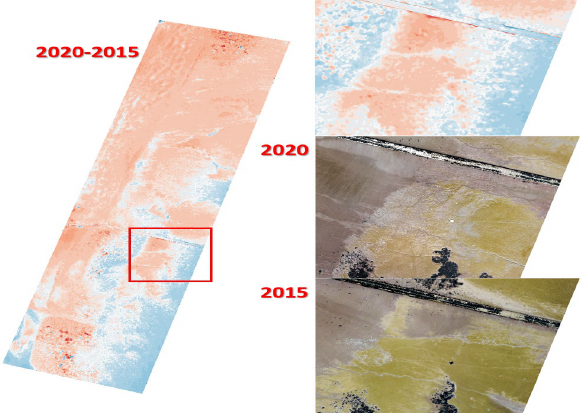
Figure 13 - Erosion & Accretion Map for the UAV Derived